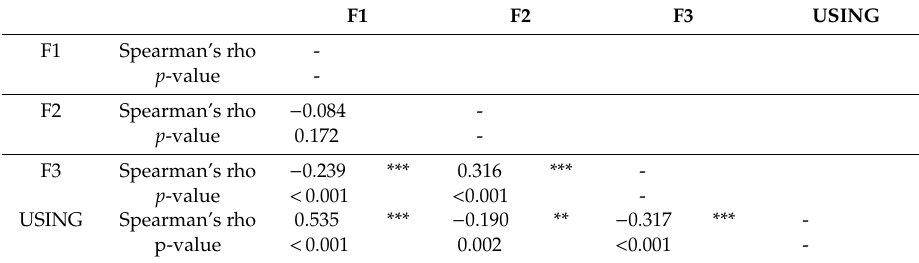
Table 2. Matrix of correlations between